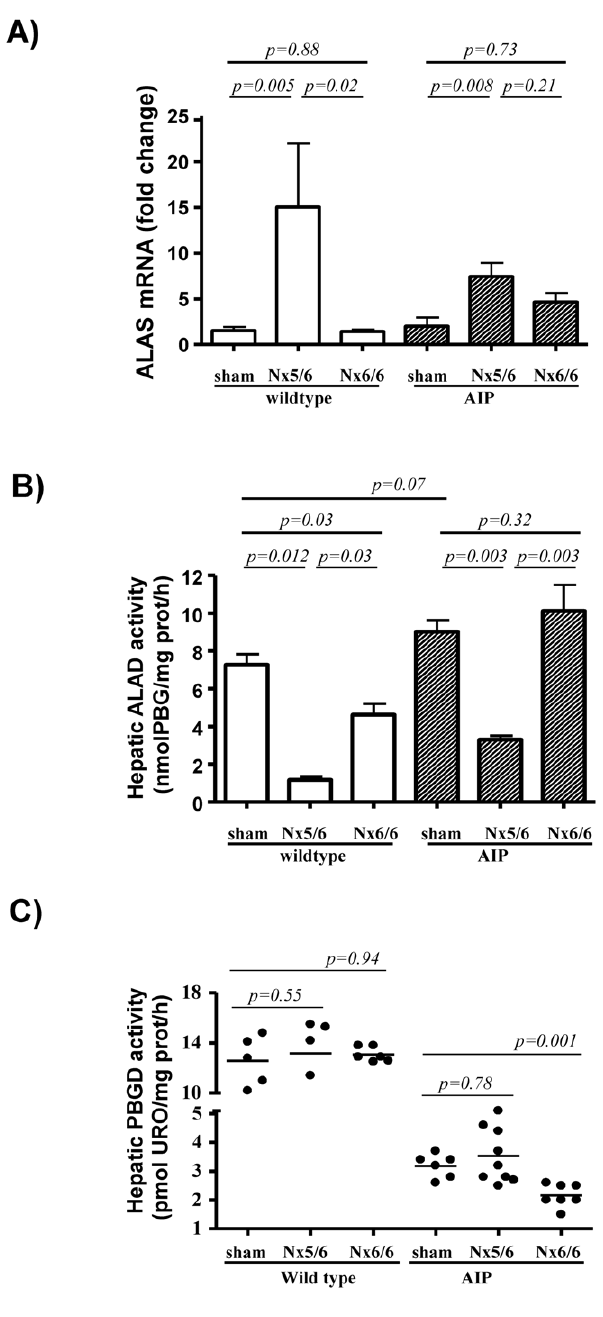
Figure 4. Expression profile of hepatic ALAS, ALAD and PBGD in male wild type and AIP mice suffering from different degrees of renal insufficiency. A group of 5 wild type and 8 AIP male animals were subjected to 5/6 nephrectomy (5/6 Nx) while complete bilateral nephrectomy was performed in 4 wild type and 6 AIP mice. A group of 6 wild type and 8 AIP male animals were sham- operated. A) Quantitative real-time PCR analysis of ALAS mRNA, B) enzyme ALAD and C) PBGD activities measured in the liver of wild type and AIP male animals. The non-parametric Mann–Whitney U-test was used for comparison of two groups. Nx5/6, 2/3 nephrectomy of the left kidney and extirpation of the right kidney; Nx 6/6, total nephrectomy. ALAS, hepatic aminolevulinate acid synthase; ALAD, aminolevulinate acid dehydratase; AIP, Acute Intermittent Porphyria.